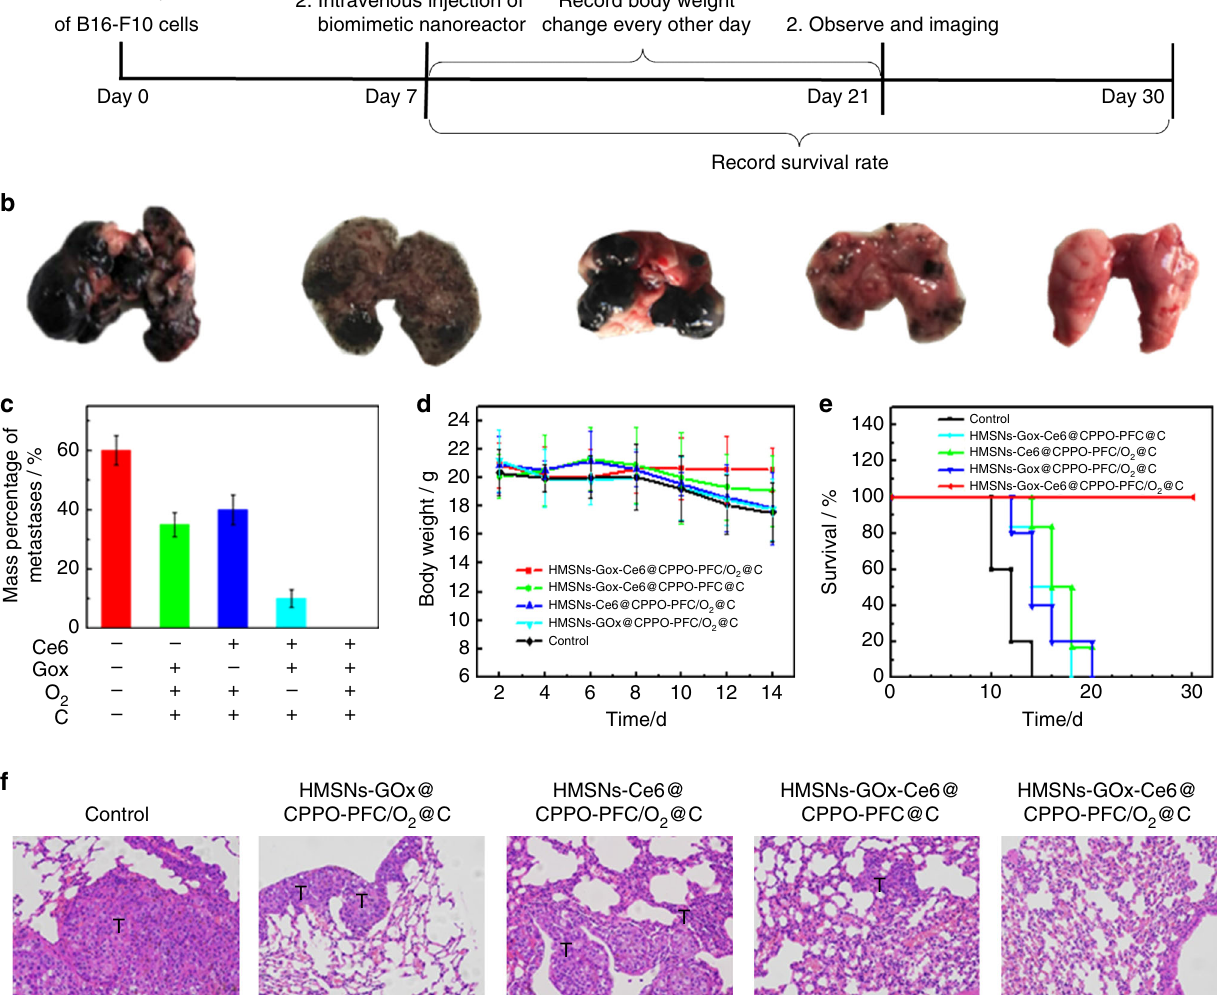
Fig. 5 Therapeutic effects of the bio-NRs in vivo. a Schematic illustration of the in vivo therapeutic process. b Macroscopic images of lungs receiving different treatments. From left to right: control, HMSNs-GOx@CPPO-PFC/O 2 @C, HMSNs-Ce6@CPPO-PFC/O 2 @C, HMSNs-GOx-Ce6@CPPO-PFC@C, and HMSNs-GOx-Ce6@CPPO-PFC/O 2 @C. c The mass percentage of metastases. Mass percentage of metastases/% = weight of metastatic tumors/ weight of normal lung. d Body weight curves of mice with metastatic tumors in each group. e Survival rates for each group after receiving treatments. f H&E staining of lung-bearing metastatic tumors after different treatments (×200, scale bars are 100 μ m). T =